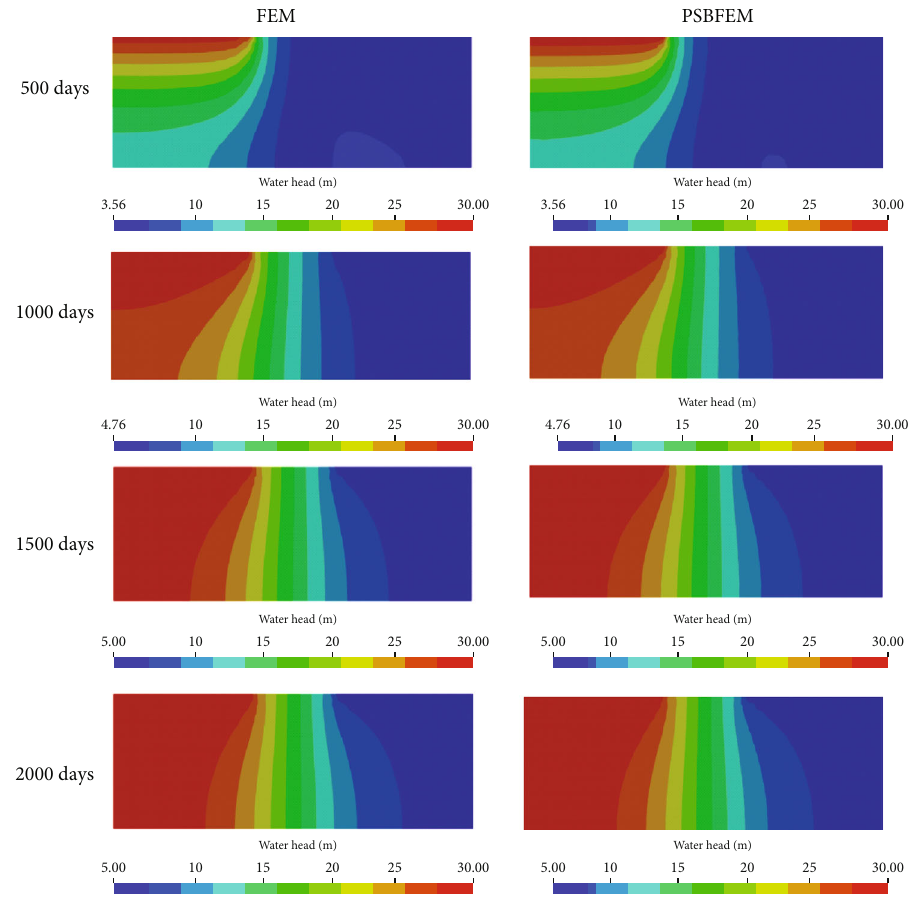
Figure 17: Comparison of the FEM and PSBFEM for the water head distribution at di ff erent